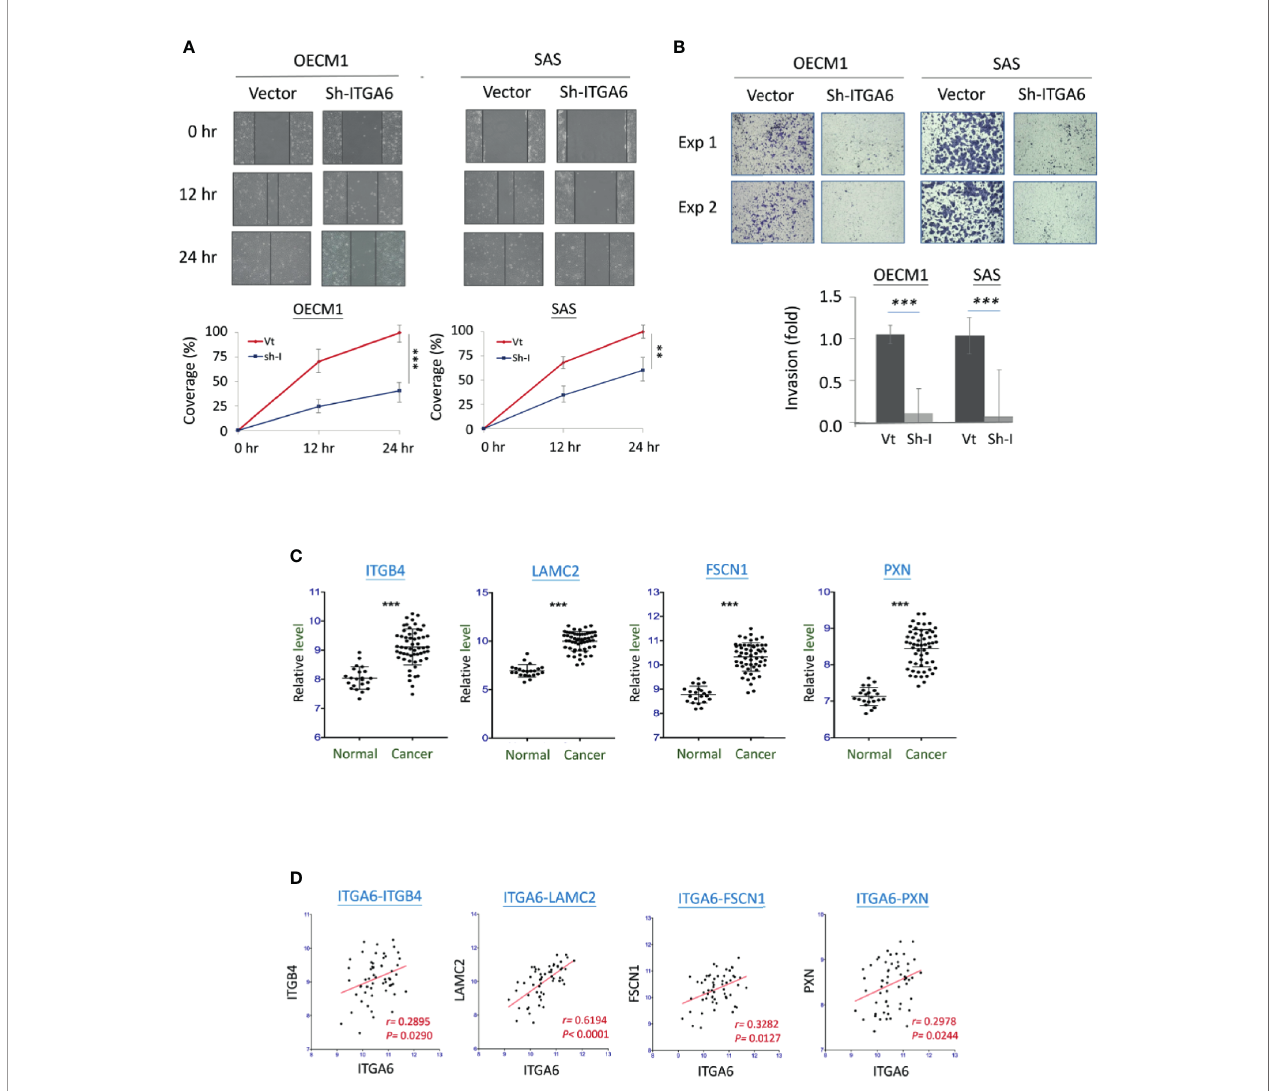
FIGURE 5 | ITGA6 promoted cell motility via regulating the integrity of extracellular matrix (ECM). (A) ITGA6 silencing decreased cell migration. After transfection of ITGA6-shRNA plasmids, the HNC cells (OECM1, SAS) were subjected to in vitro wound healing assay. Cell migration toward the gap was observed, photographed, and quanti fi ed at the indicated times. (B) ITGA6 silencing attenuated cell invasion. After transfection of ITGA6-shRNA plasmids, the HNC cells (OECM1, SAS) were subjected to Matrigel invasion assay. The cells that invaded through the Matrigel-coated membranes to the reverse side were stained, photographed, and quanti fi ed. (C) Signi fi cant increases of ECM-associated gene expressions in the oral cancer tissues from HNC patients (Cancer) compared to the oral mucosa specimens from healthy individuals (Normal). The gene expression data, including ITGB4, LAMC2, FSCN1, and PXN, was retrieved from GEO Datasets GSE25099. (D) Correlative expressions between ITGA6 and ECM associated molecules ITGB4, LAMC2, FSCN1, and PXN, in the oral cancer tissues from HNC patients. The gene expression data was retrieved from GEO Datasets GSE25099. (**p < 0.01, ***P < 0.001,